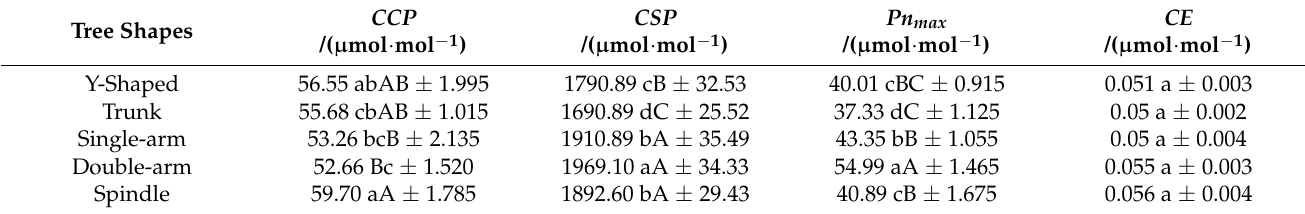
Table 4. CO 2 response curve parameters.